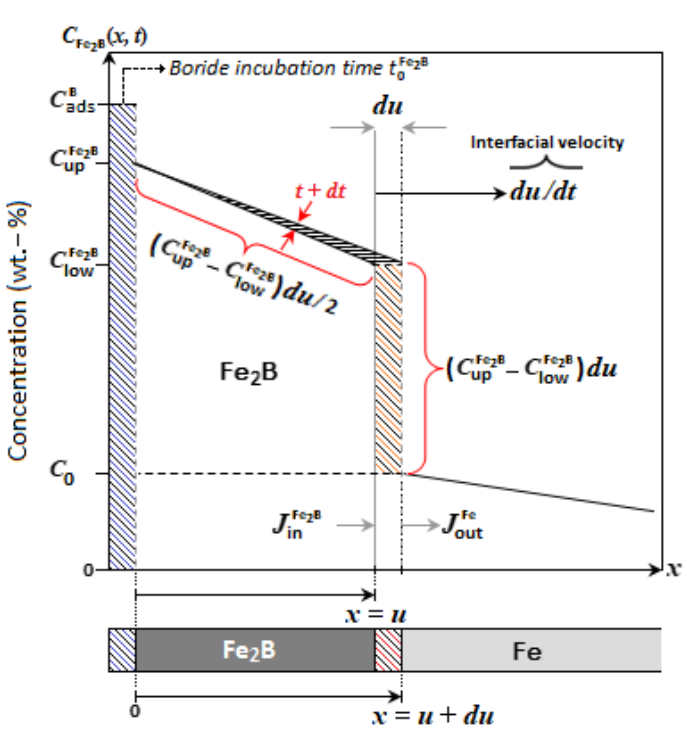
Figure 4. Schematic boron concentration profile through the Fe 2 B layer.